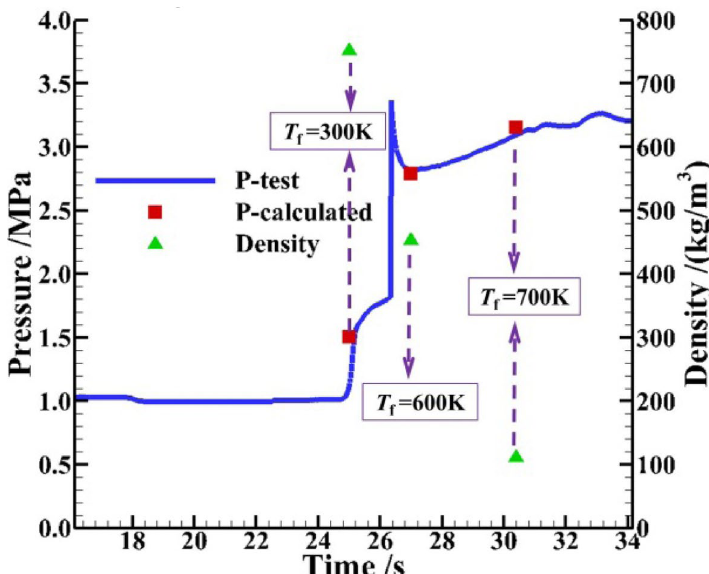
Fig. 10 The comparison of the injecting pressure between test and